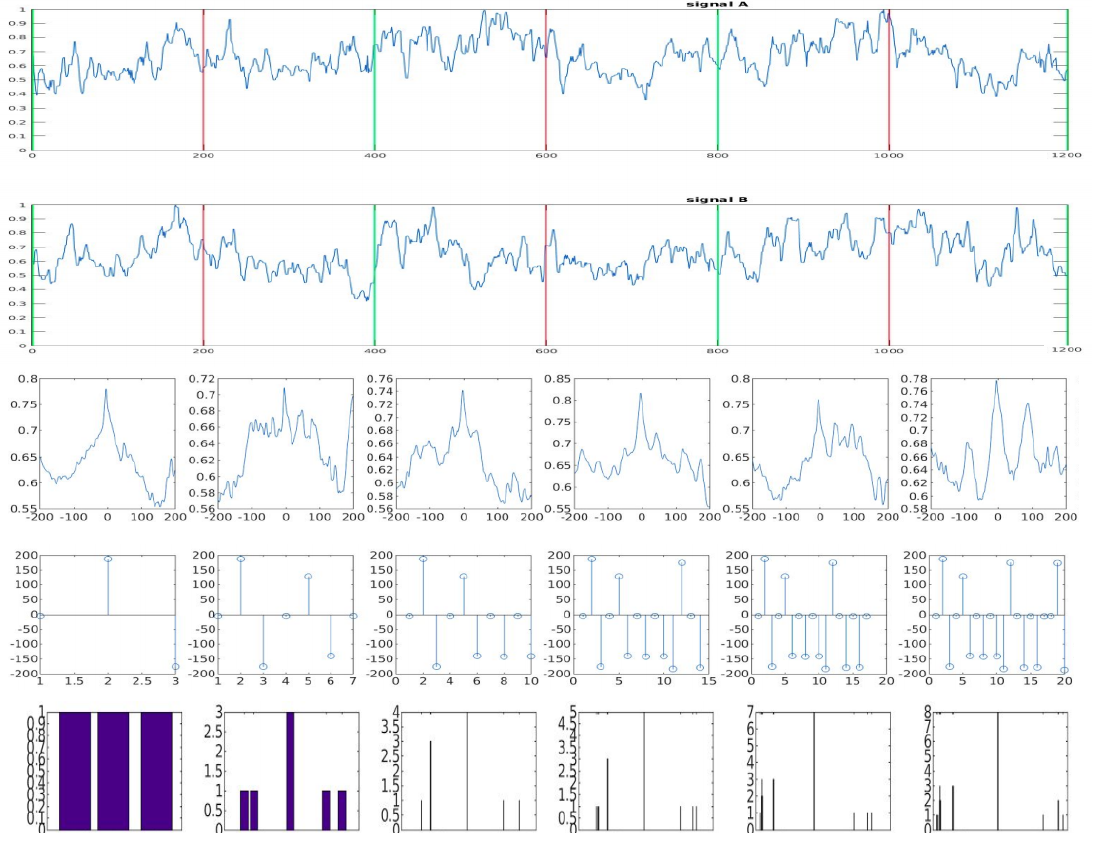
Figure 4. Signal flow of the proposed synchronization algorithm; N = 400, O . R . = 2, σ = 0.20, N . C . = 3, and ± ∆ R =